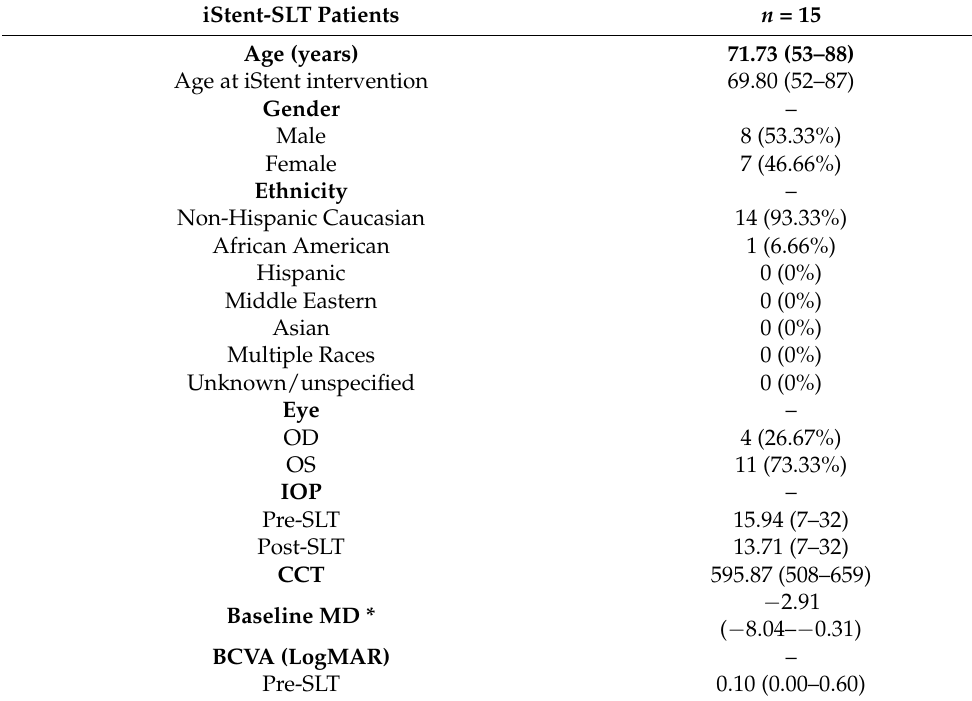
Table 1. Demographic factors of iStent-SLT patients